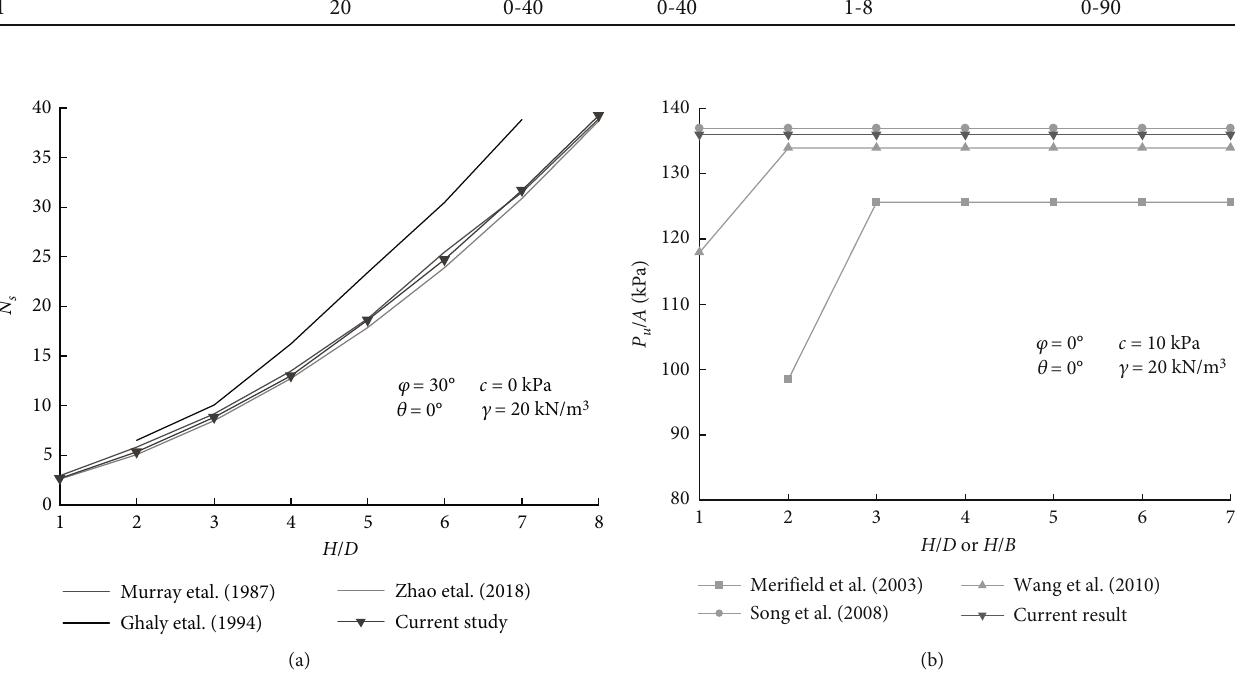
Figure 3: Variation and comparison of pullout capacity with available data in existing literature for anchor plate at di ff erent H / D for (a) c = 0 kPa and (b) φ = 0 °